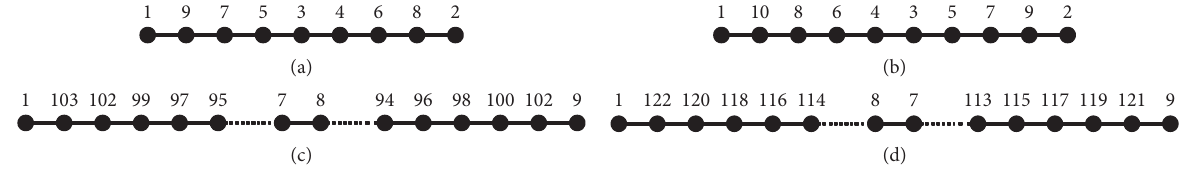
,P , P , and P . (a) rmsn( P 9 ) � 9. (b) rmsn( P 10 ) � 10. (c) rmsn( P 96 ) � 103. (d) rmsn 9 10 96 115